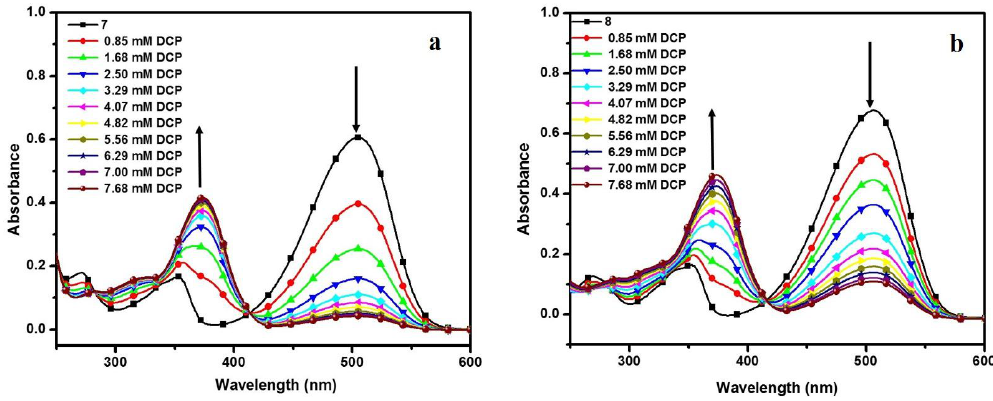
Figure 5. UV-Vis absorption spectra upon titration of compounds 7 ( a ) and 8 ( b ) with DCP.